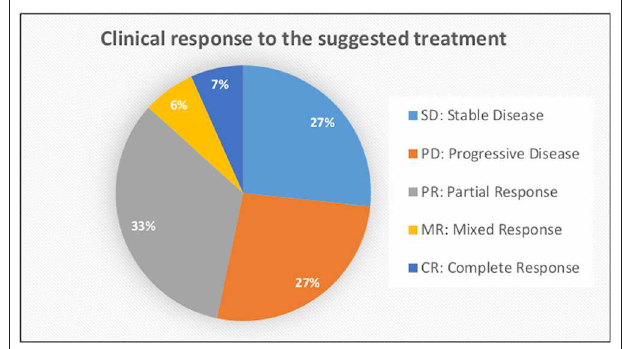
FIGURE 2 | Data analysis showing the clinical response to the personalized treatment for all patients included in this study.